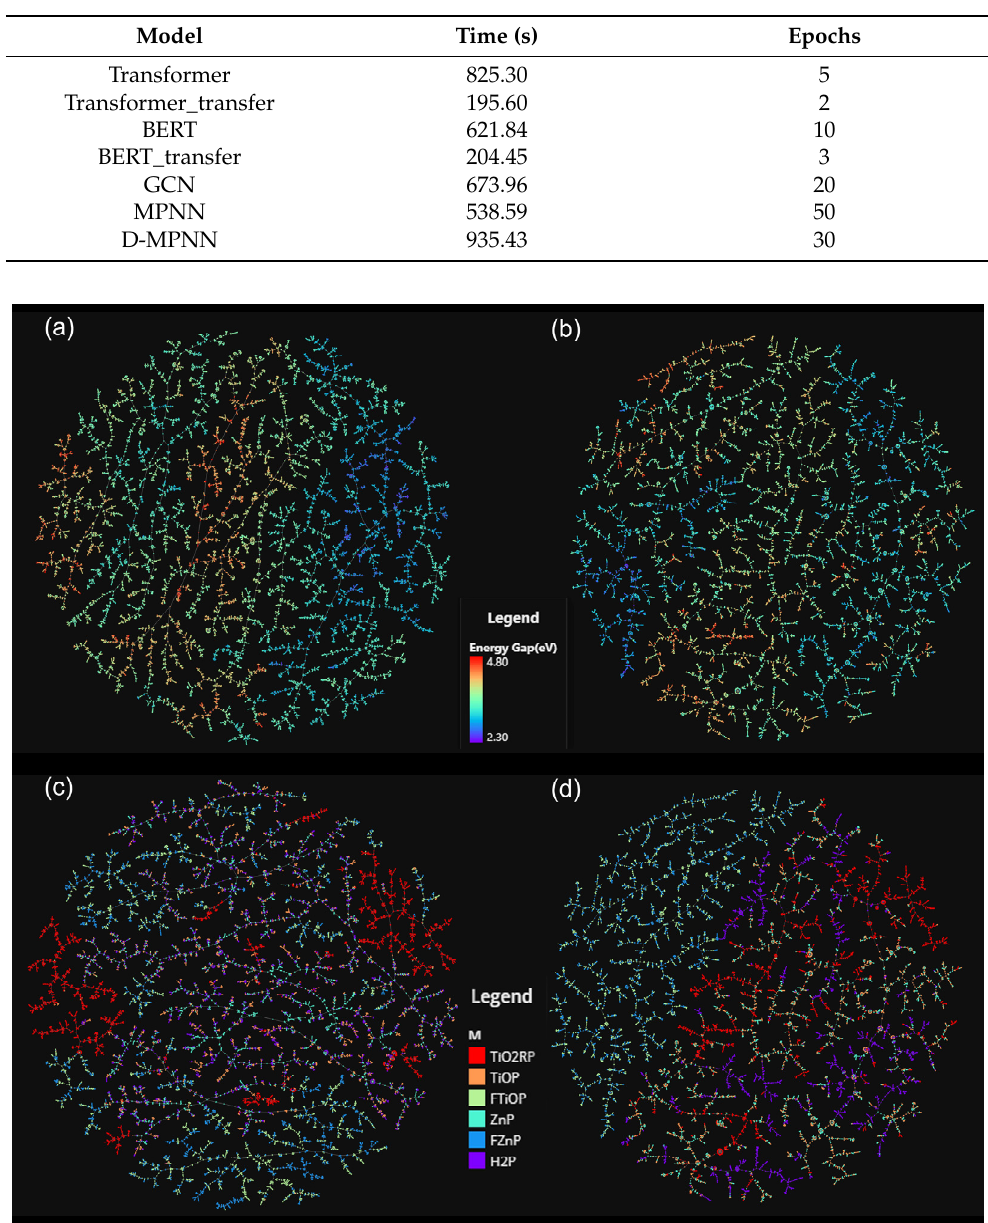
Table 1. Training time and epochs for each model.